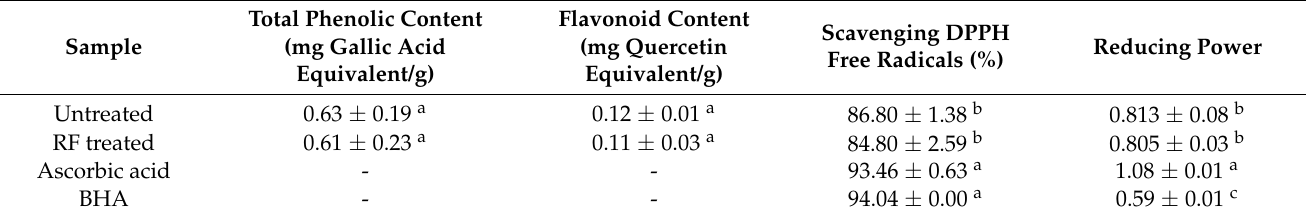
Table 2. The antioxidant components and activities analyses of the RF-treated rice